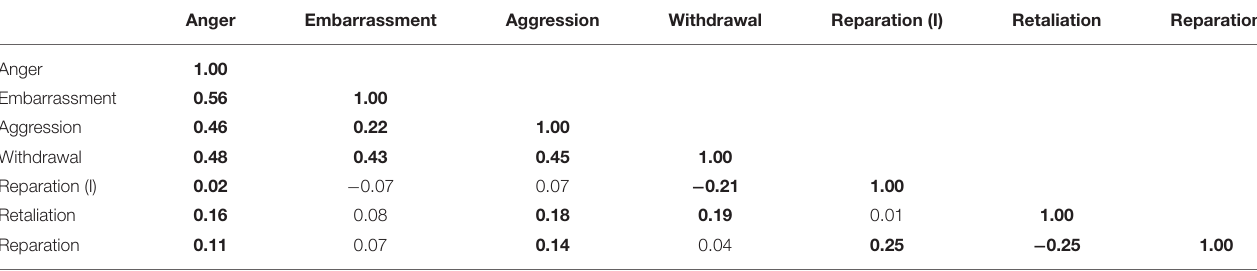
TABLE 2 | Correlation matrix of all dependent variables.